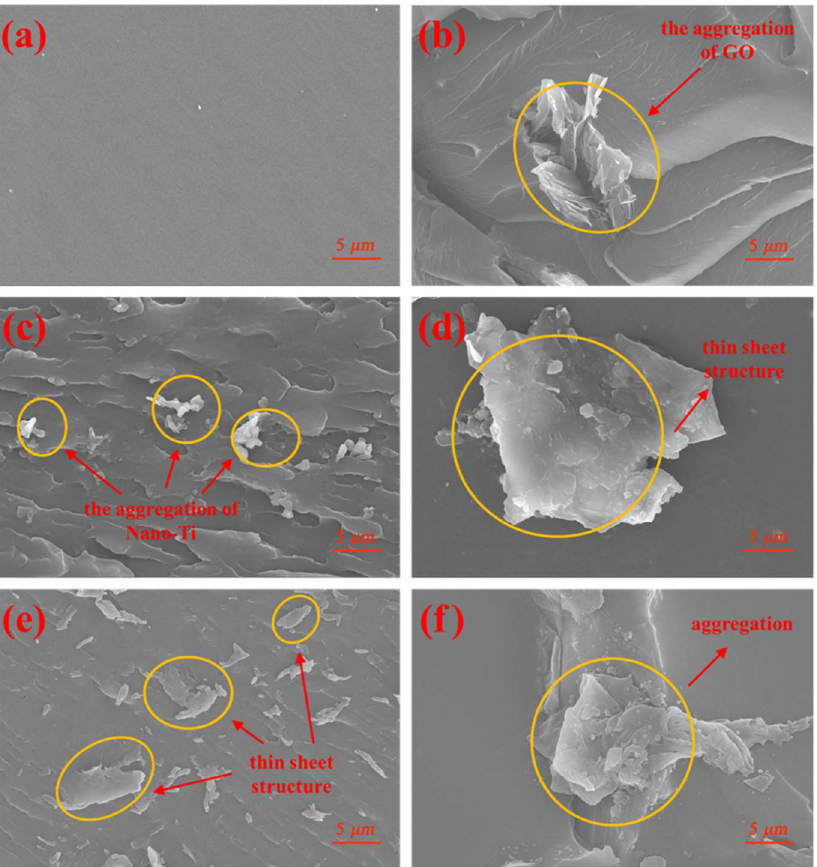
Figure 7. Fracture surface of ( a ) epoxy resin (EP), ( b ) GO/EP, ( c ) Ti/EP, ( d ) GO-Ti (1:1)/EP, ( e ) GO-Ti (2:1)/EP, and ( f ) GO-Ti (3:1)/EP.